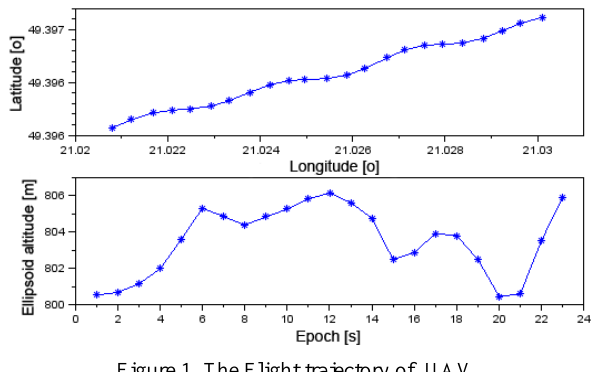
Figure 1. The Flight trajectory of